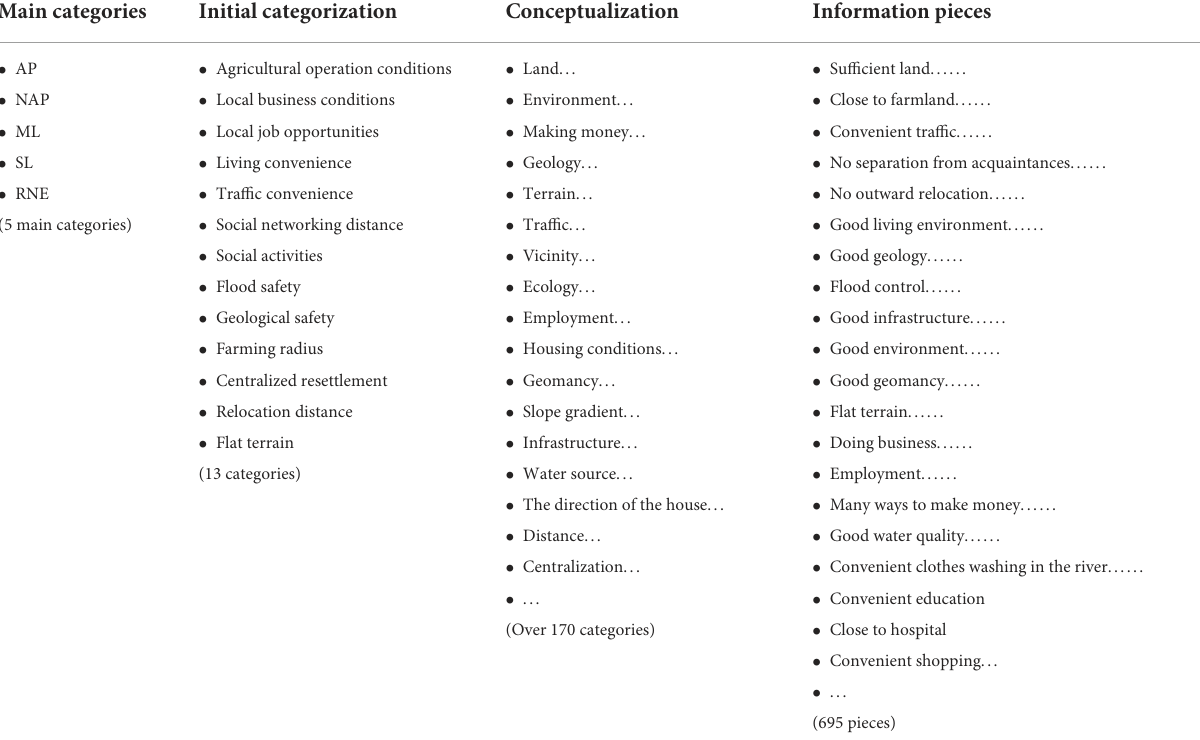
TABLE 1 Resettlees’ expectations for resettlement